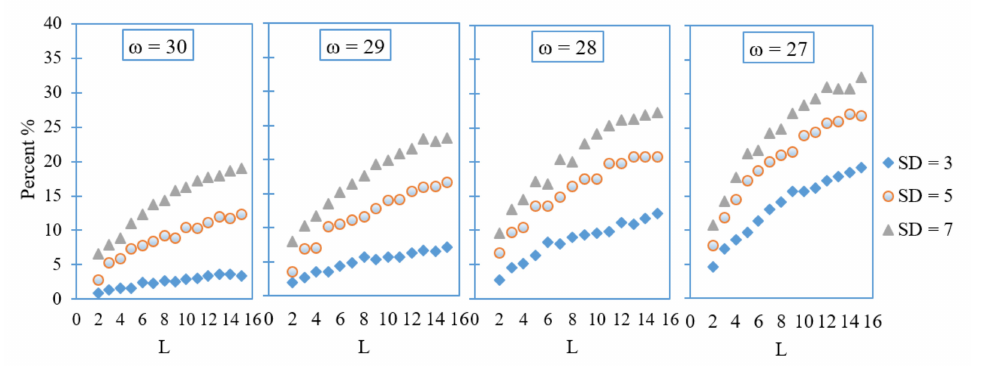
Figure 5. Percent of useful batches.